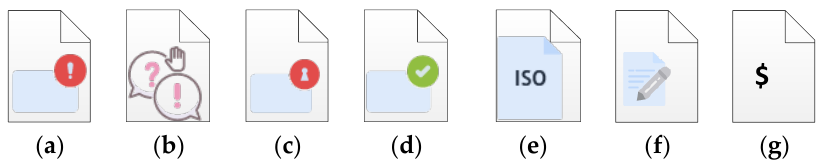
Figure 6. Visual representation of different types of data objects in the BPMN extension. ( a ) critical, ( b ) important, ( c ) proprietry, ( d ) regulatory, ( e ) sensitive, ( f ) form, ( g ) valuable.